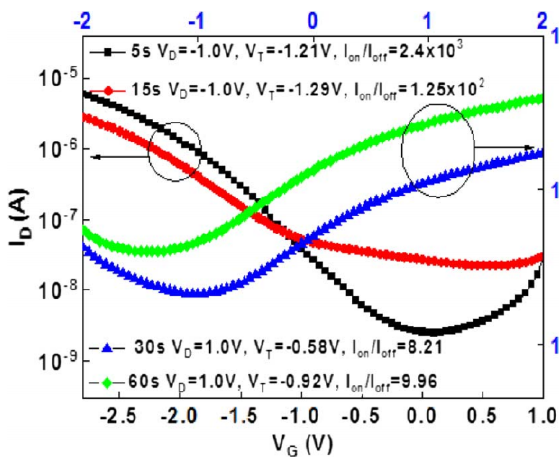
Figure 13: Transfer characteristics of SnO TFTs with bipolar conduc- tion under oxygen plasma treatment on the channel with different exposure time [71]